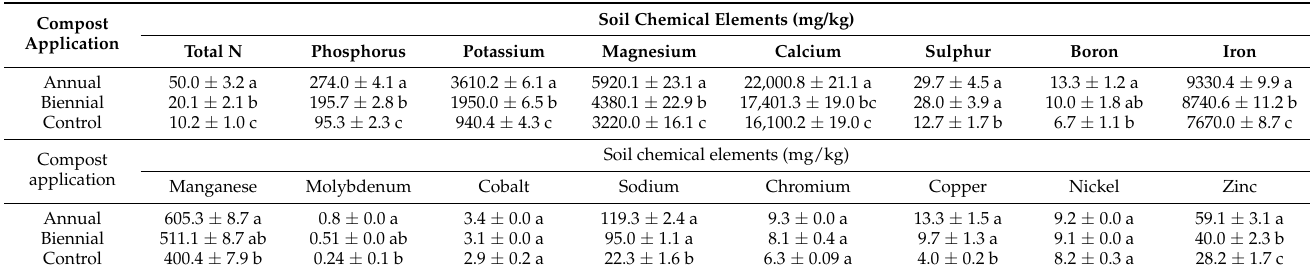
Table 2. Five-year accumulation of essential and beneficial chemical elements in soils as affected by frequency of application of municipal solid waste